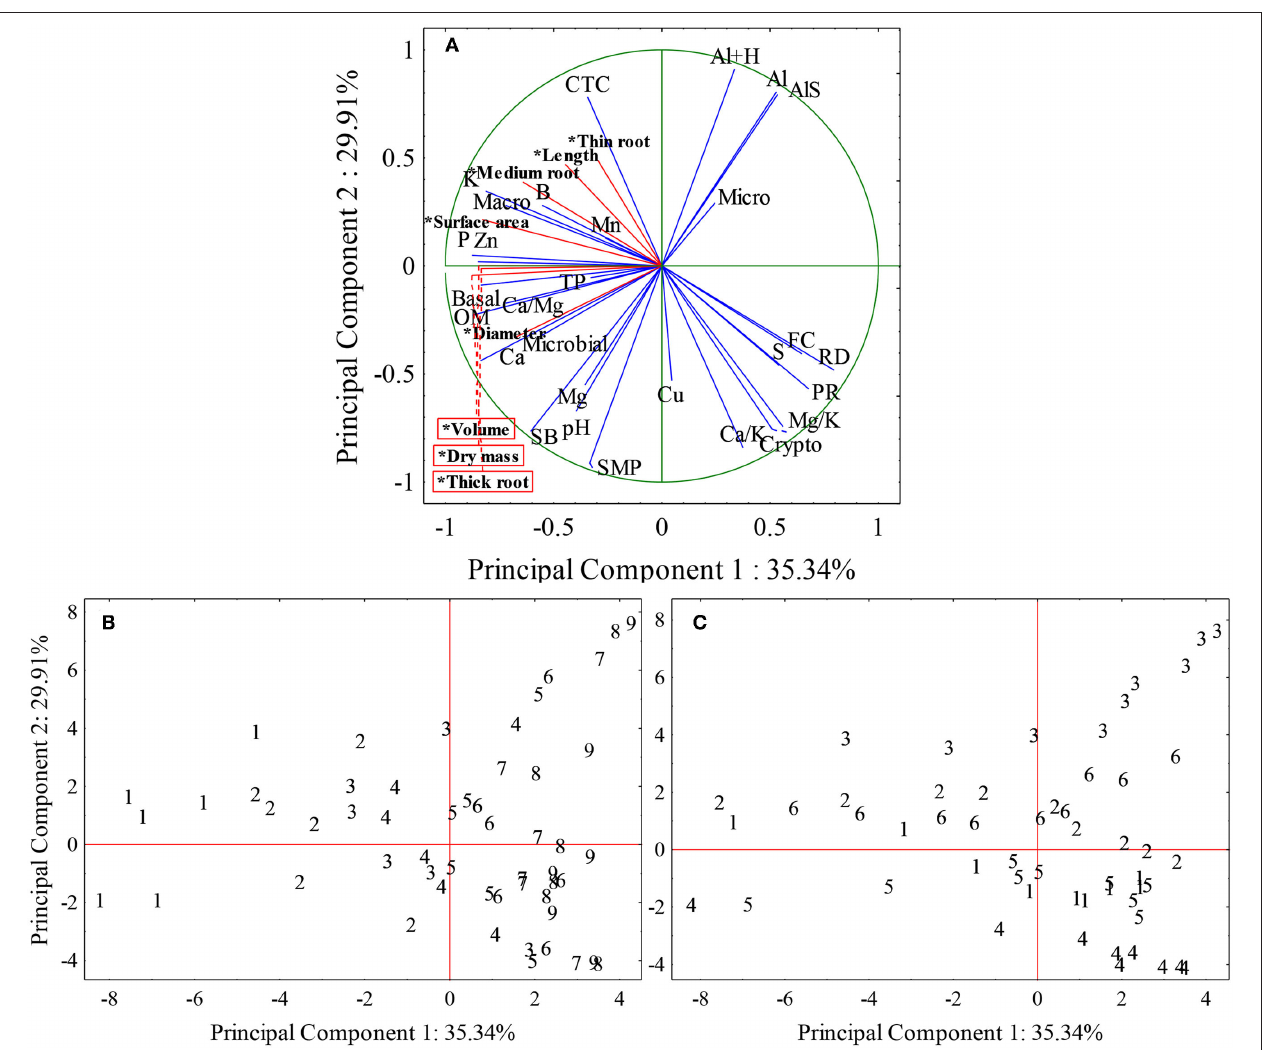
FIGURE 10 | Spatial projection of vectors of chemical, physical, and biological attributes of the soil and radicial growth in different places and depths of the soil. (A) Cloud distribution chart of root growth variables and soil chemical, physical, and biological attributes, *Supplementary variables (radicial growth – red lines). (B) Depth distribution graphic. (C) Distribution graphic of the locations. Fine roots ( < 0.5mm); Medium roots (0.5–2mm); Thick roots ( > 2.0mm), pH, Hydrogenionic potential; SMP, method of analysis and correction of soil acidity; P, Phosphorus (mg dm − 3 ); K, Potassium (mg dm − 3 ); OM, Organic matter (%); Al, Aluminum (cmol c dm − 3 ); Ca, Calcium (cmol c dm − 3 ); Al + H, Aluminum + Hydrogen (cmol c dm − 3 ); SB, Sum of bases (%); AlS, Aluminum saturation (%); Ca/Mg, Calcium, magnesium ratio; Ca/K, Calcium potassium ratio; Mg/K, Potassium magnesium ratio; S, Sulfur (mg dm − 3 ); Zn, Zinc (mg dm − 3 ); Cu; B; Mn; TP, Total porosity (m 3 /m 3 ); Macro, Macropores (m 3 m − 3 ); Micro, Micropores (m 3 m − 3 ); Crypto, Cryptopores (m 3 m − 3 ); PR, Soil penetration resistance (MPa); FC, Field capacity (m 3 m − 3 ); RD, Relative density; Basal, Basal respiration (mg kg − 1 of soil); Microbial, Microbial biomass (mg kg − 1 of